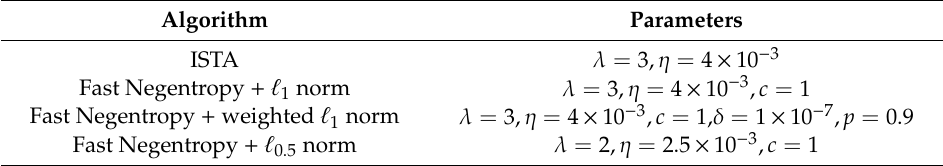
Table 1. The parameter setting of